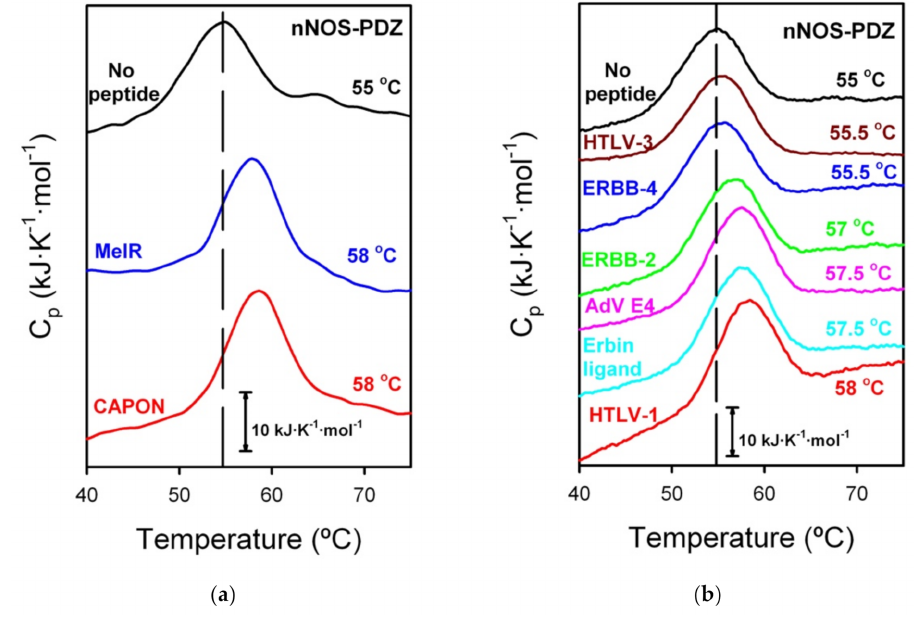
Figure 3. DSC experiments of nNOS-PDZ with the eight peptides of this study. In both panels, the nNOS-PDZ denaturalization without any peptide is also shown as reference, in black. We made two sets of experiments, ( a ) with cognate ligands and ( b ) with non-cognate ligands, including, in both sets, the nNOS-PDZ alone. The T m is noted next to each calorimetric trace in the same color code (“Erbin ligand” refers to the phage-display designed ligand for Erbin). A bar indicating 10 kJ · K − 1 · mol − 1 is depicted as a